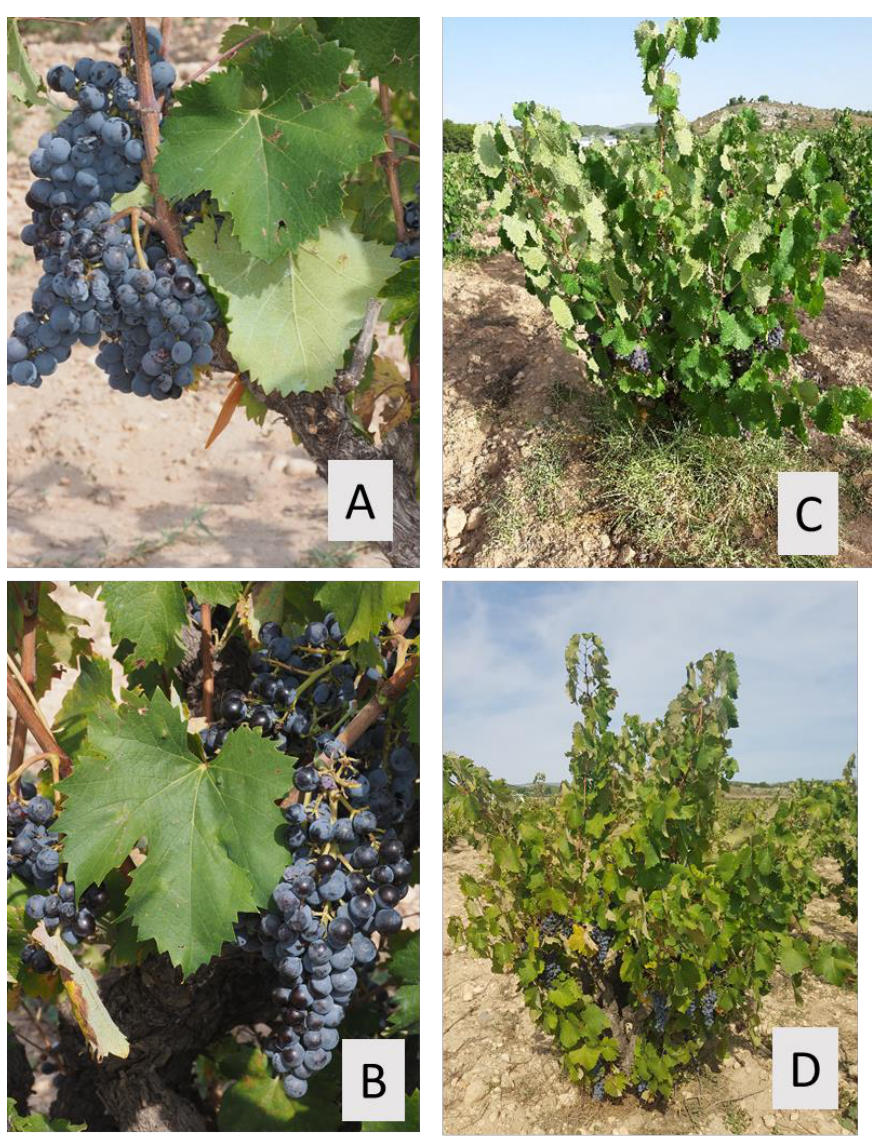
Figure 2. Bunches, leaves, and vines of cv. Monastrell ( A , C ) and Veremeta ( B , D ). Forcallat had circular hepta-lobulated leaves, with straight teeth and a petiole with a U-shaped sinus and lateral sinuses that were very marked and deep. Its bunches were conical and medium in size with broad ellipsoid berries of an herbaceous flavor (Table 1). It showed an upright growth (Figure S2B). Forcallat leaves had the highest L (luminosity) and b (blue – yellow opponents) on both sides of the leaf with respect to all the other varieties (Table S3). Garnacha had the highest intensity coloration on the prostrate hairs of the tip and smaller bunches in comparison to the other varieties. Its bunches were funnel-shaped and had berries with a non-particular flavor (Table 1). Garnacha had a high vigorous growth (Figure S2C) and high fertility (data not shown). All the assayed varieties, with the exception of Garnacha, had leaves with a cottony underside with prostrate hairs between the veins of the leaves. Bobal stood out by the erect hairs on the veins on the undersides of its leaves and the weight of its clusters, which had the biggest grapes. Its bunches were compact, similar to those of Garnacha and Monastrell (Table 1, Figure